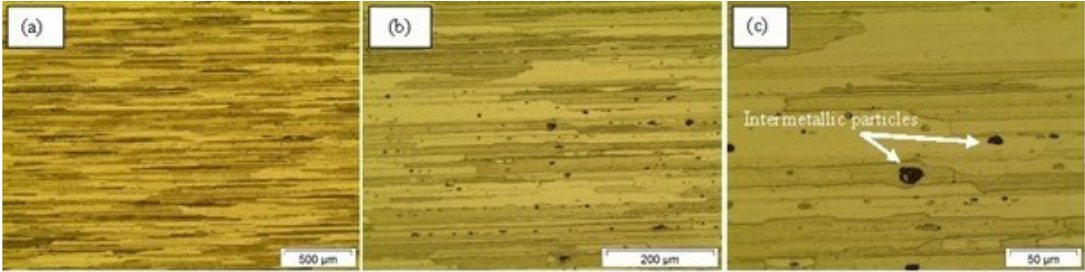
Figure 5. Observed microstructure of the AA 7075-T651 alloy, with magnifications of: a) 50x, b) 200x and c)